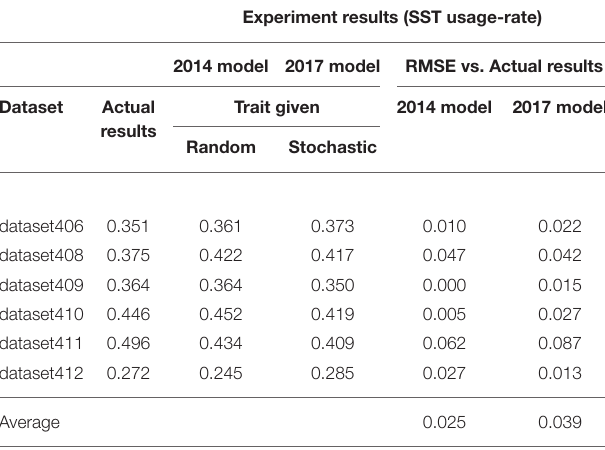
TABLE 2 | Experimental results of the SST adoption models of 2014 and